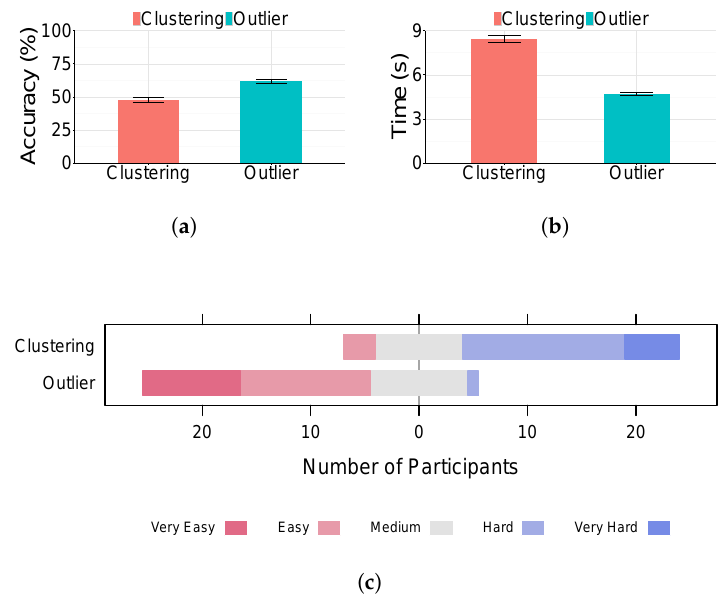
Figure 9. Clustering vs. outlier task. ( a ) Task accuracy (higher is better); ( b ) Task completion time (lower is better); ( c ) User preference.